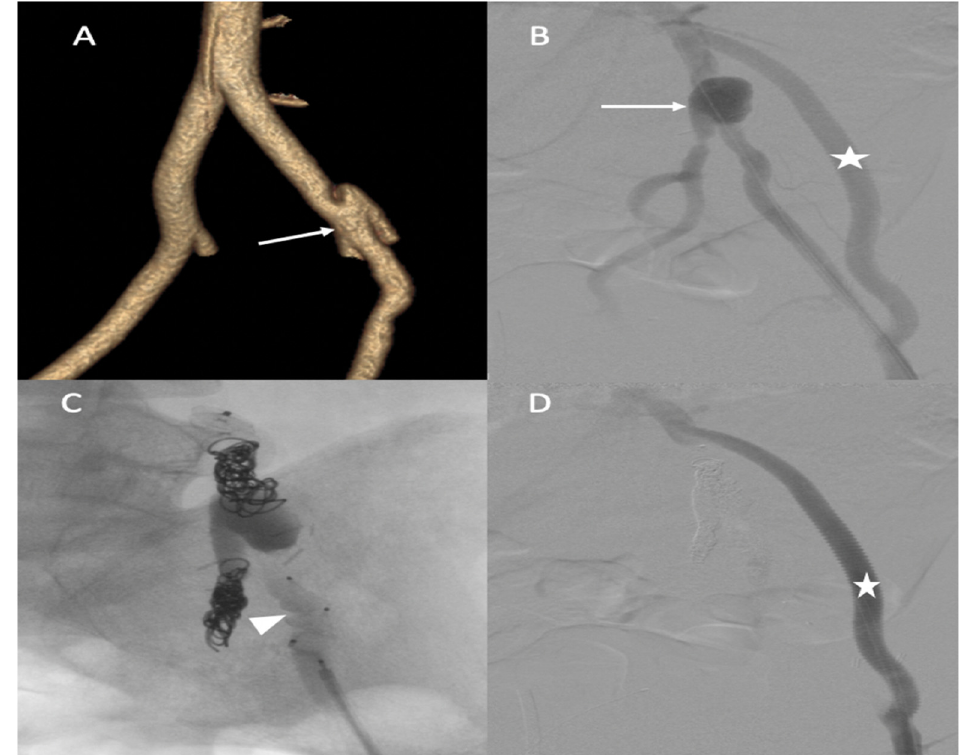
Figure 4. ( A ) Abdominal CT angiogram with 3D image showing the dissection of the left common iliac artery (arrow); ( B ) arteriography shows the left iliofemoral bypass (star) and dissection of the left common iliac artery (arrow); ( C ) occlusion of the left internal and external iliac arteries by coils and then a plug (head arrow); ( D ) arteriography final shows the permeability of left iliofemoral bypass (star).